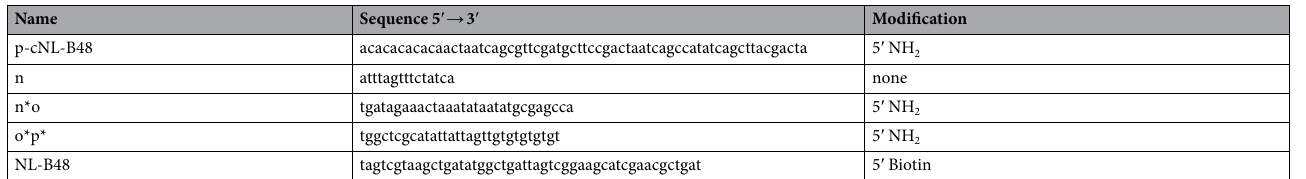
Table 3. Oligonucleotide sequences to form DNA nanostructures. Part n is complementary to part n*; part o to part o *; p to p* and cNL-B48 is complementary to NL-B48, which is already immobilized on the gold electrode of the switchSENSE device (without Biotin). For ELISAs, NL-B48 was ordered with 5´ Biotin to attach it to NeutrAvidin on the ELISA